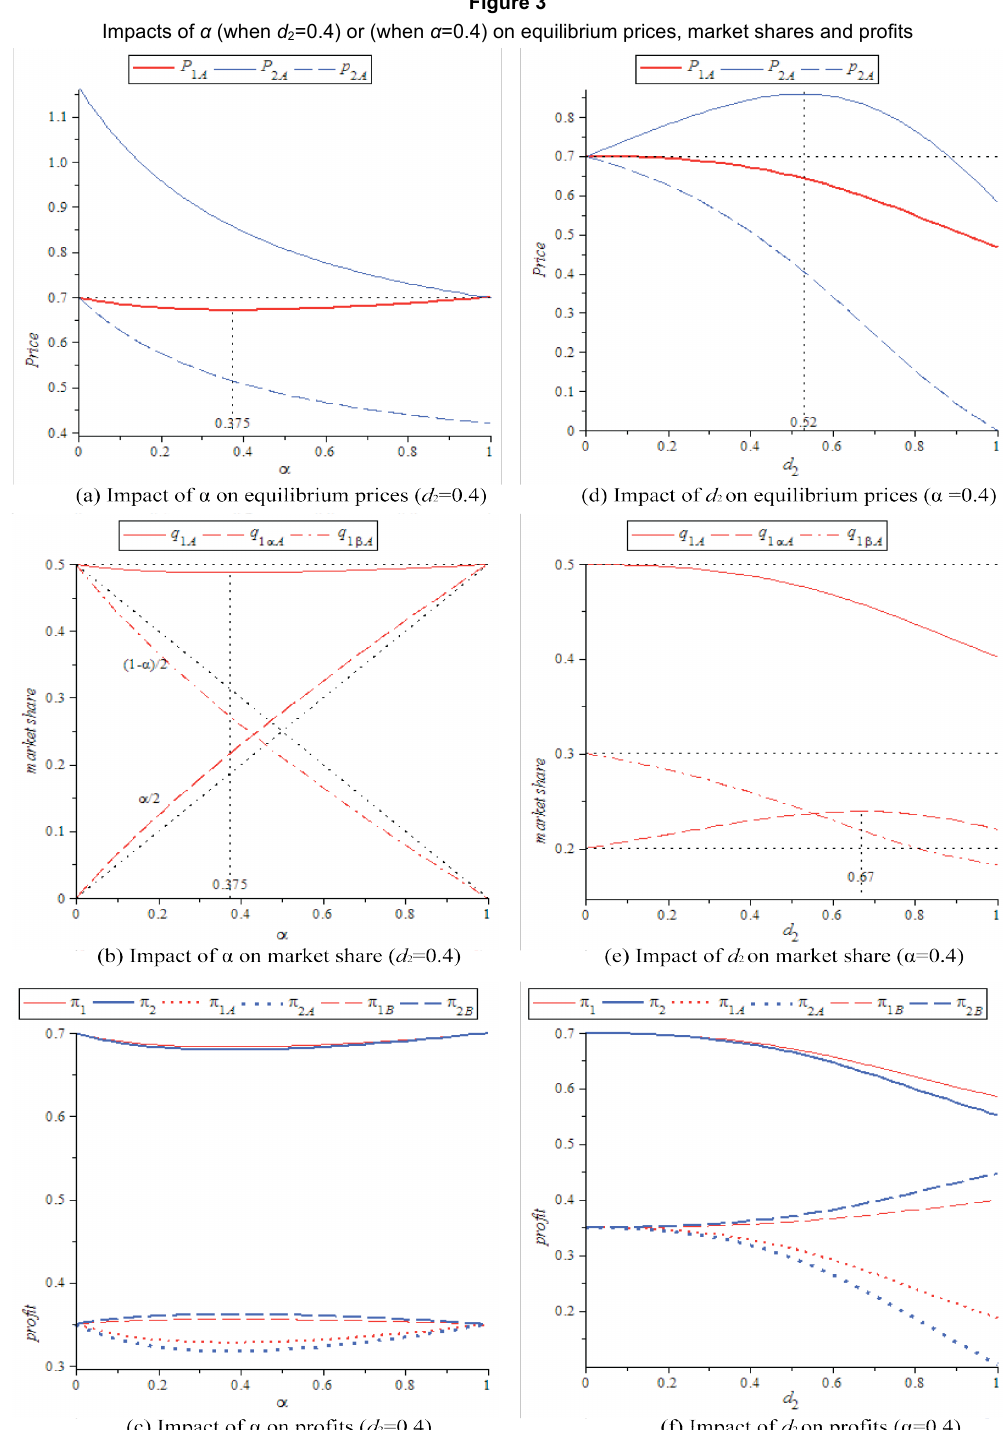
Impacts of α (when d 2 =0.4) or (when α =0.4) on equilibrium prices, market shares and